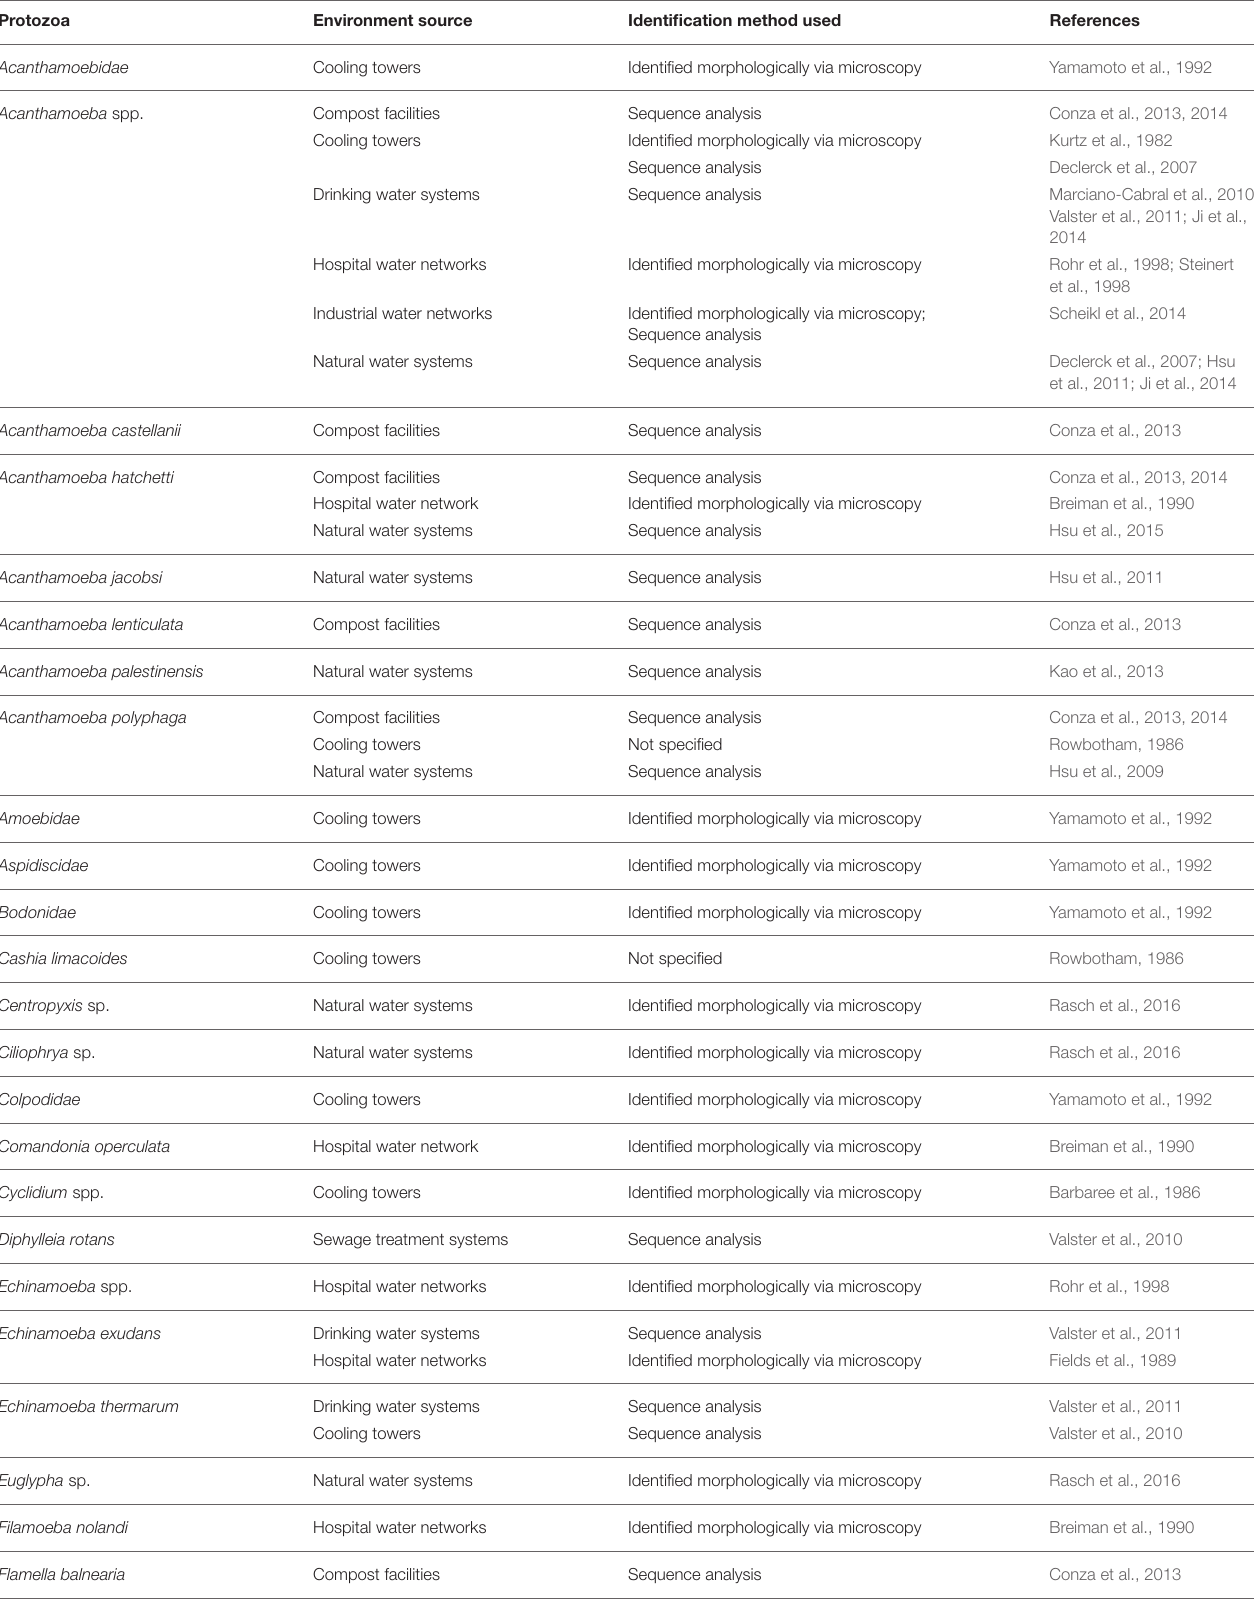
TABLE 2 | Suggested protozoan hosts of L. pneumophila